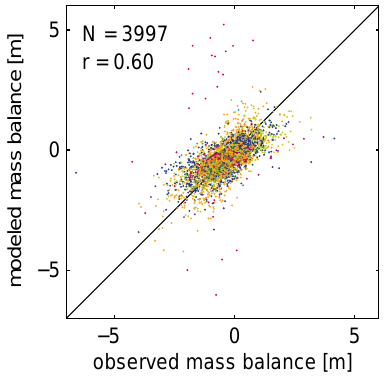
Fig. 8. Cross-validation results; observed versus modeled mass bal- ances; numbers indicate correlation (significant above 95% confi- dence interval) and sample